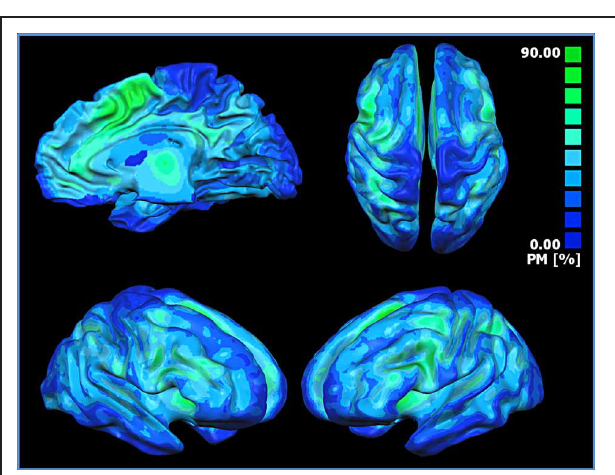
FIGURE 5 | Probabilistic map showing the superposition of the MACM of all blocks. The probabilistic map shows the probability of overlap between each block-related MACM map. The probability map is calculated by summing the voxel value of each block-related MACM map and dividing this value by the number of blocks. Single network maps before the creation of the probability maps were thresholded at p < 0 . 05, minimum cluster size k > 100mm 3 . Regions in blue are characterized by a low probability of overlap, whereas green regions present a high probability of